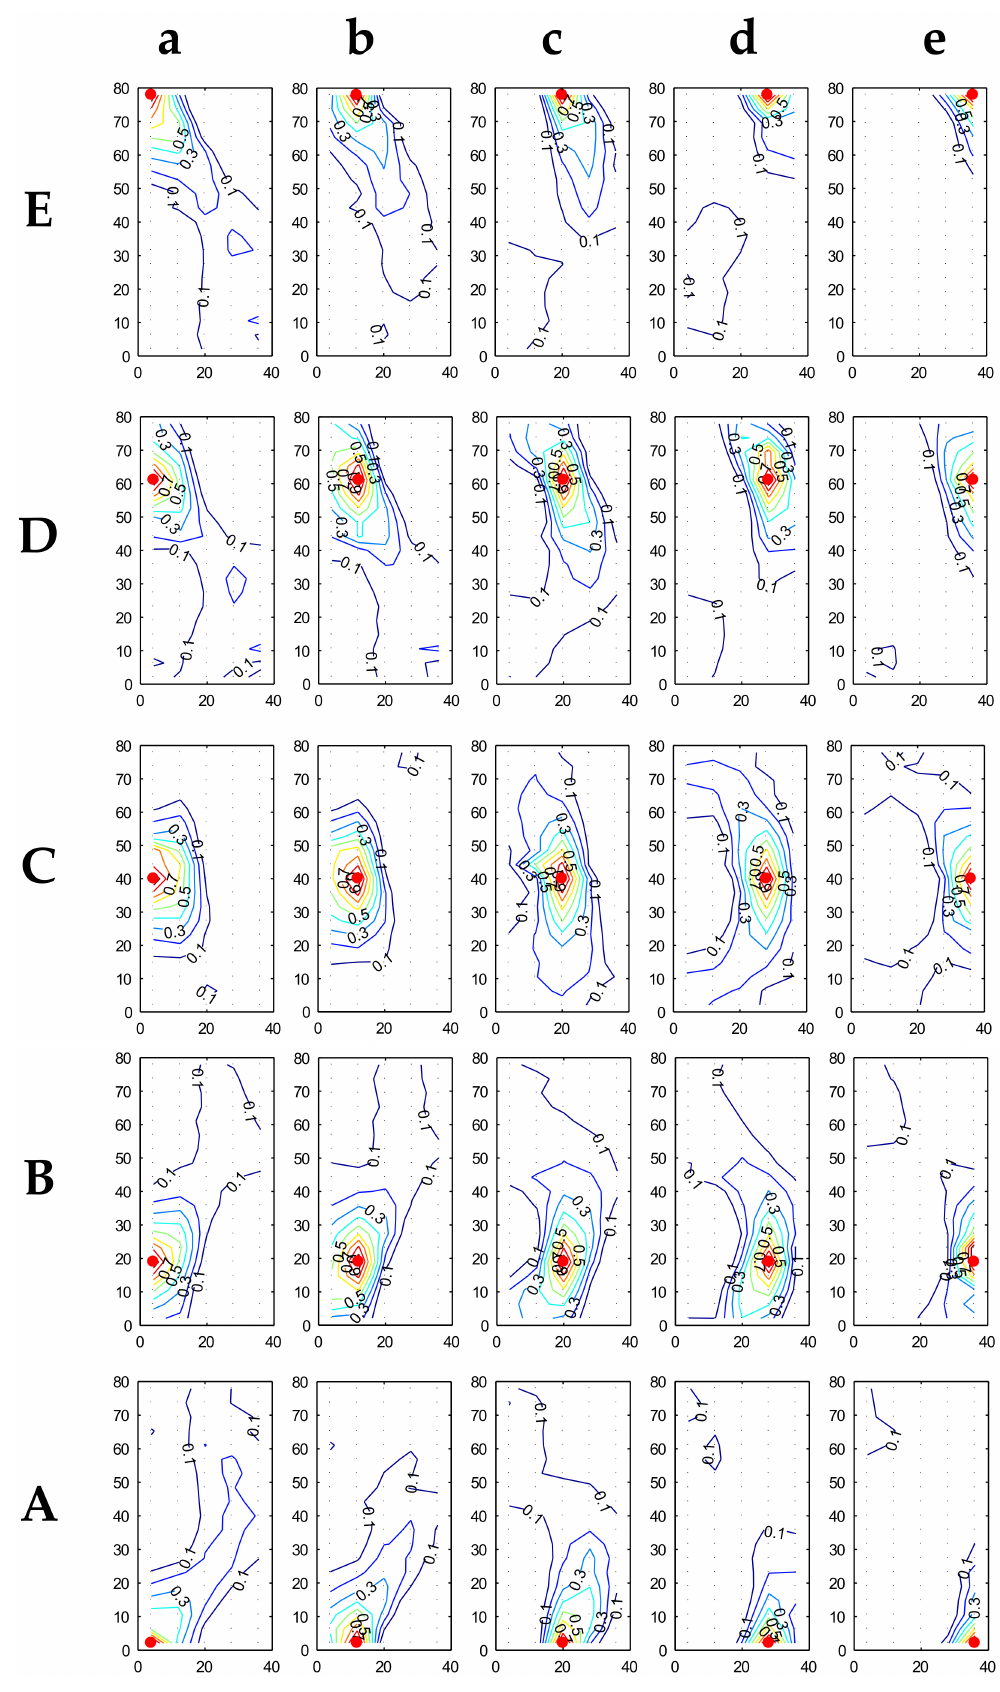
Figure 16. Correlation coefficient trend for RHF at 90 ◦ . Color bar as in Figure